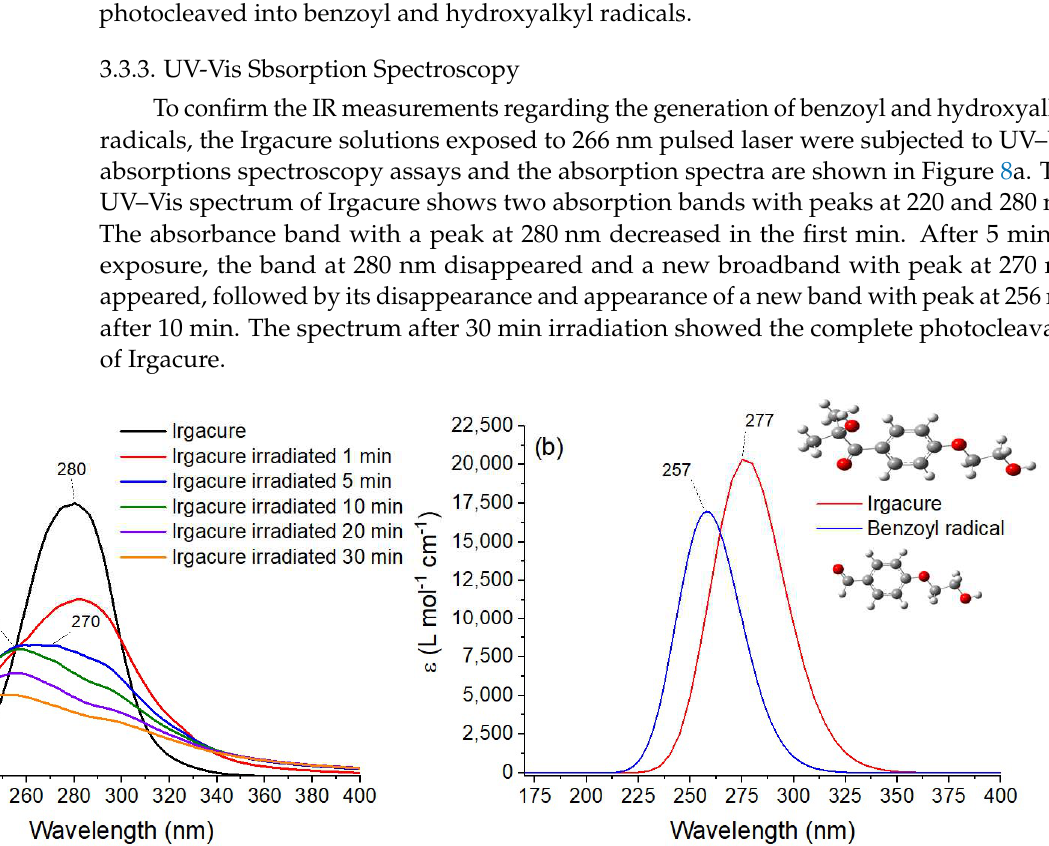
Figure 8. ( a ) UV–Vis absorption spectra of Irgacure (0.05% w / v ) exposed to 266 nm laser pulsed radiation at an energy of 0.75 mJ up to 30 min; ( b ) UV–Vis spectra of Irgacure and benzoyl radical resulting from DFT B3LYP 6-311(d,p) computation with Gaussian 09.